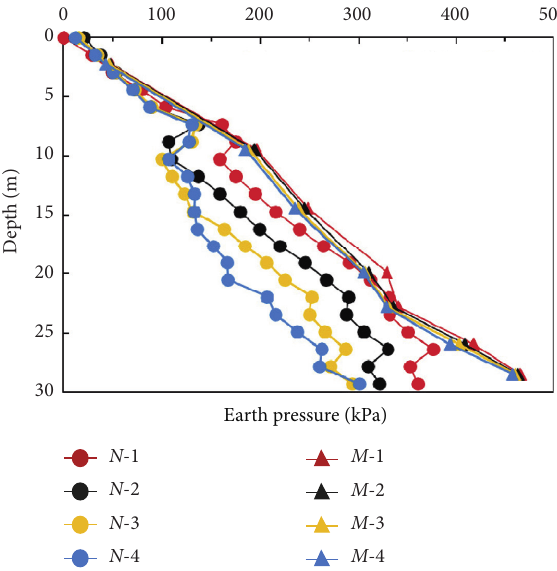
Figure 12: Earth pressure behind the wall of